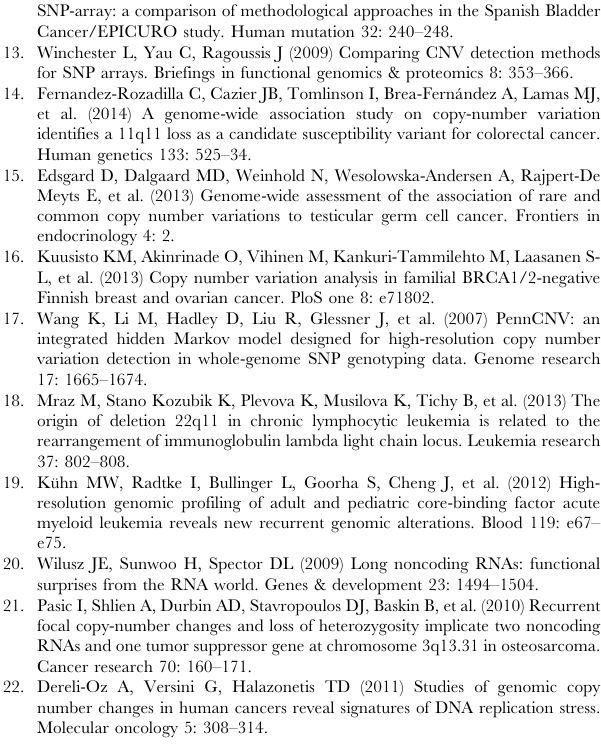
Table S1 Primers designed to amplify the LOC2831772 region on 11q25. Table S2 Aberrations found in the DLBCL cases at nominal P , 0.05. Aberrations that remained significant after correction (P_FDR , 0.05) are shown in bold. Table S3 Aberrations found in the FL cases at nominal P , 0.05. None of these aberrations remained significant after correction (P_FDR , 0.05).